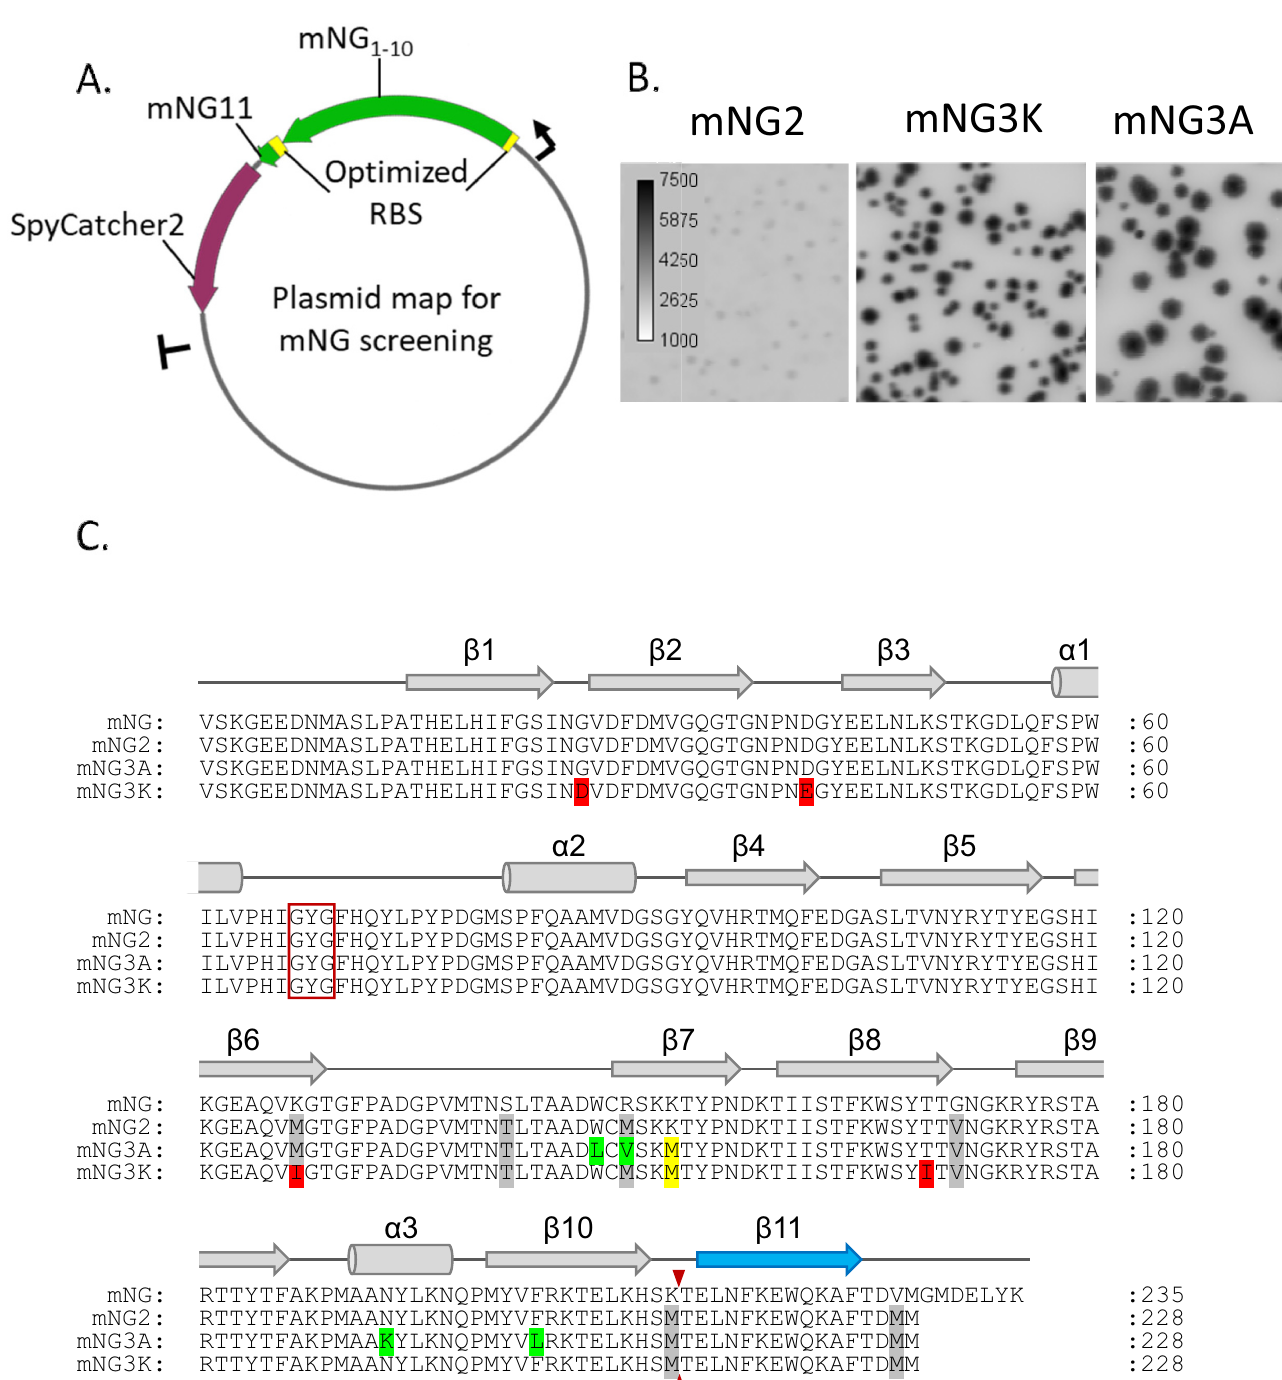
Fig 1. Identifying mNG variants with improved brightness in E. coli through directed evolution. A. Schematics of mNG screening platform; B. Fluorescence images of E. coli colonies expressing split mNG2, mNG3A and mNG3K; C. Protein sequence alignment of full length mNG, mNG2, mNG3A and mNG3K. Chromophore amino acids are indicated by a red box and the split site is indicated by the small red arrow. The position of α -helices and β -sheets are shown and numbered above the